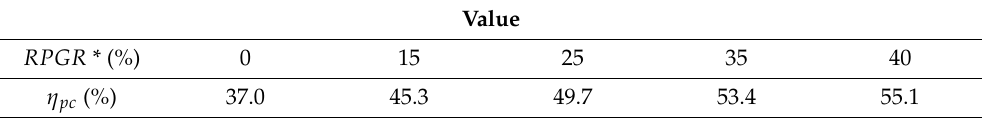
Table 3. Weighted power generation efficiency for RPES evaluation according to RPGR.